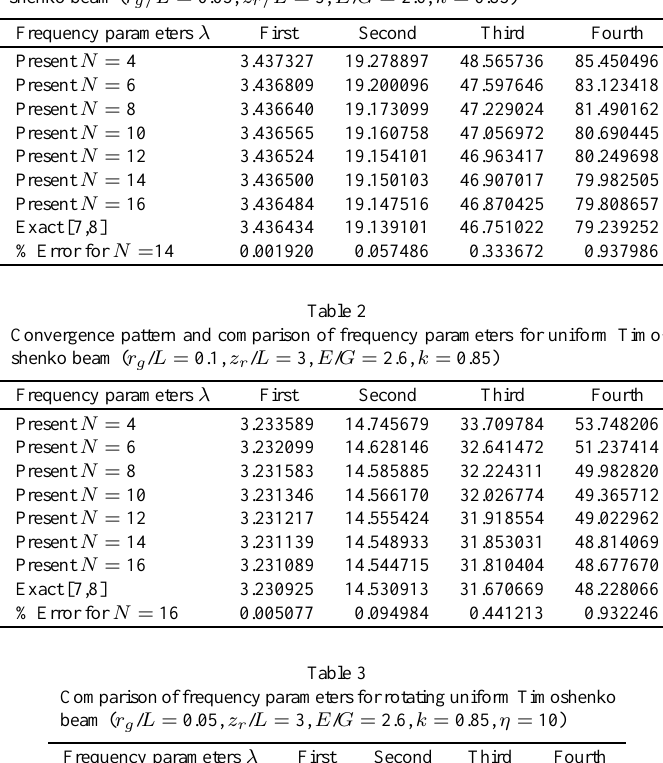
Table 1 Convergence pattern and comparison of frequency parameters for uniform Timo-